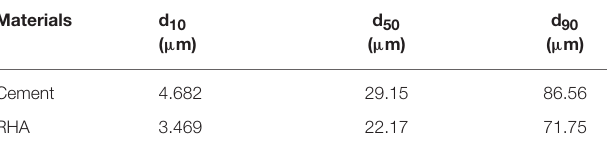
TABLE 5 | Comparison of d 10 , d 50 , and d 90 values of Cement and RHA.